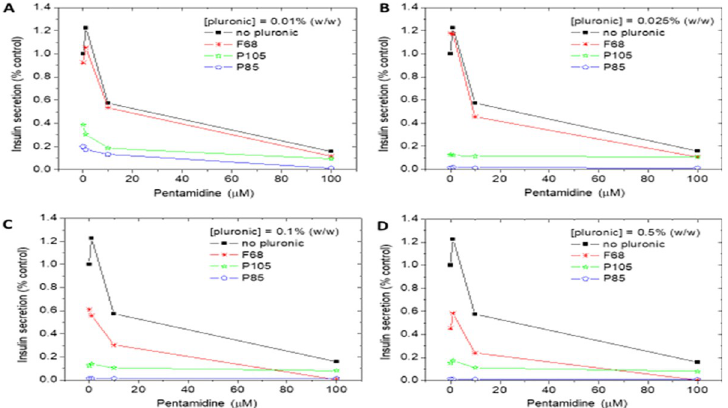
Fig 3. The effect of pentamidine and Pluronics on insulin secretion from MIN6 β -cells. (A-D) P85 and P105 induced a strong suppression of insulin secretion from MIN6 β -cells even at low concentrations. (C-D) F68 only induced insulin secretion suppression at concentrations � 0.1% w/v. Data are expressed as a percentage of insulin secretion from MIN6 β -cells incubated in the absence of pentamidine or Pluronics.